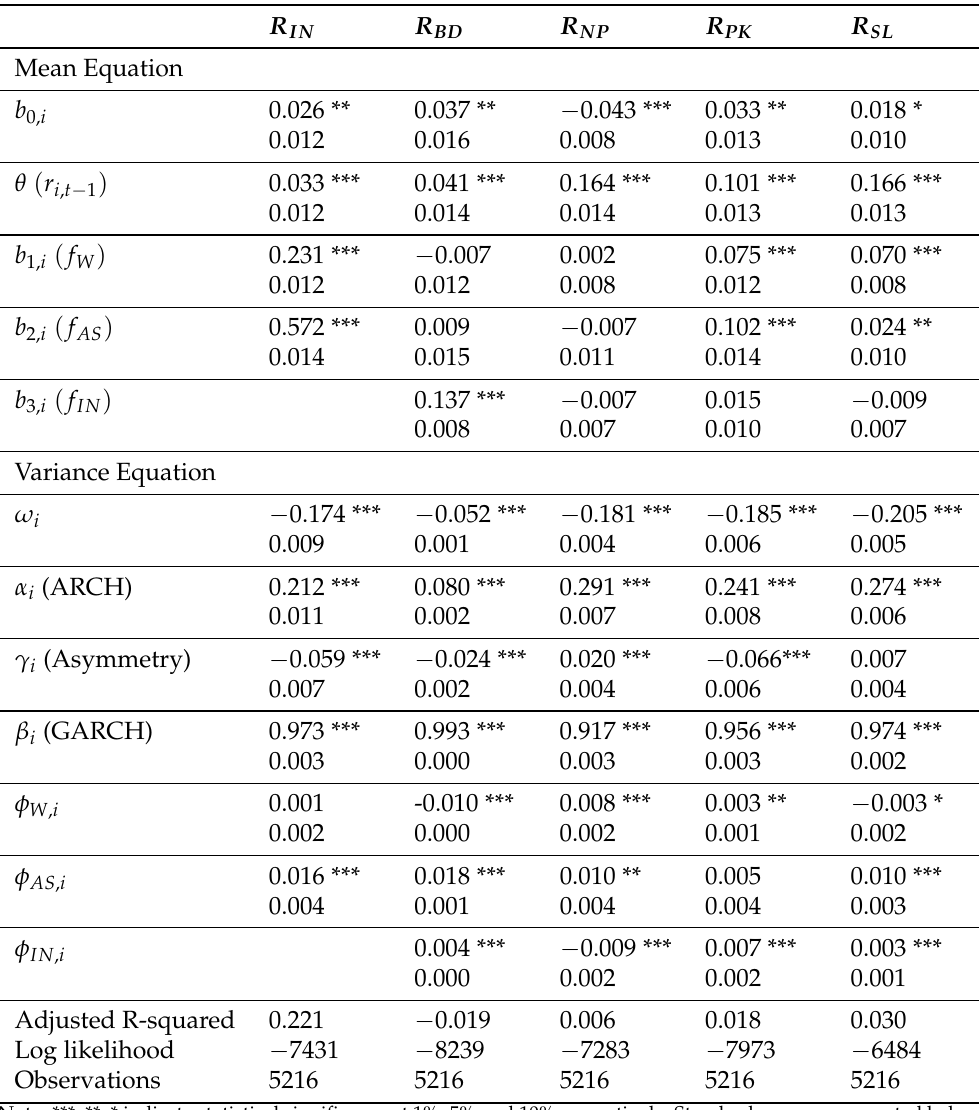
Table 5. Regression